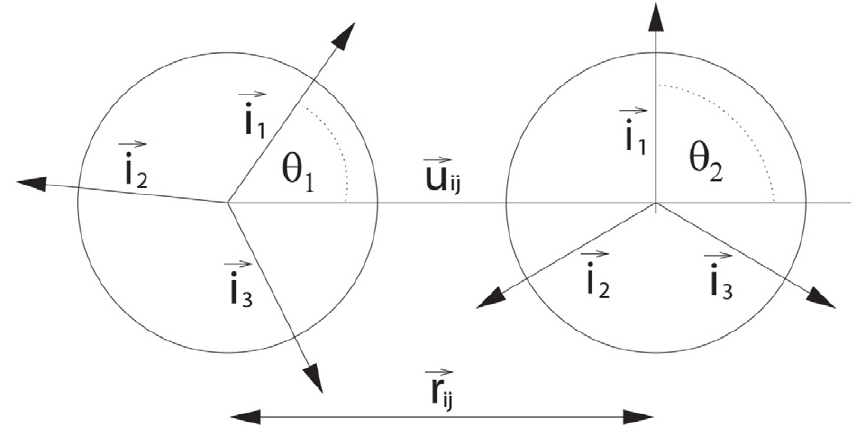
Figure 1: The MB particles in 2D.